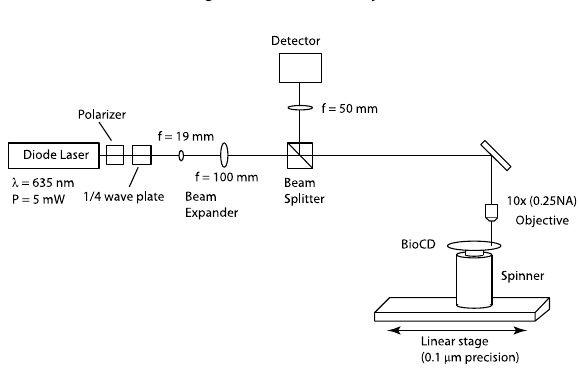
Figure 2. Optical layout for BioCD scanning. The diode laser operates at a wavelength of 635 nm. The disc is positioned on a linear translation stage with 1 μ m precision for radial scanning. The beam expander controls the beam size at the disc.